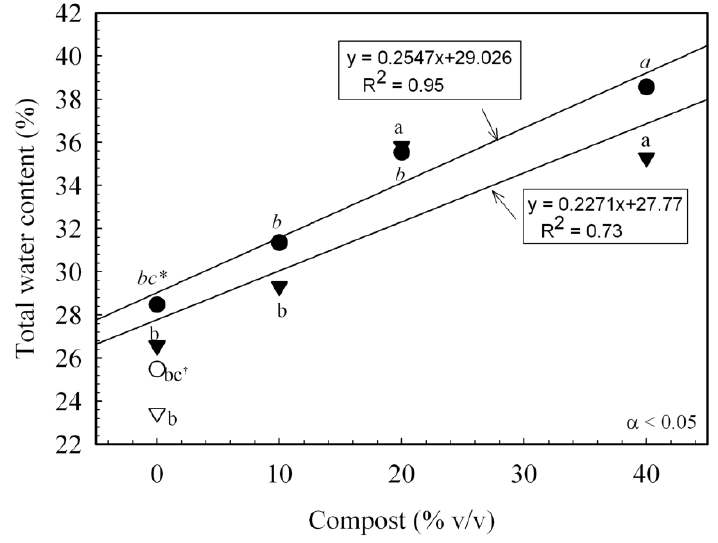
Figure 1. Effect of incorporating composted poultry litter into top 12.7 cm of subsoil on percent total water content (  ) by volume for ● sodded compost; ○ sodded fertilizer; ▼ T seeded compost; and seeded fertilizer plots; * Means with same letters are statistically insignificant based on Fisher’s Protected LSD test ( P ≤ 0.05) (italicized statistics correspond to sodded treatments); † values for standard error were small ranging between 0.085 (min.) to 0.553 (max.) and hence are not shown in